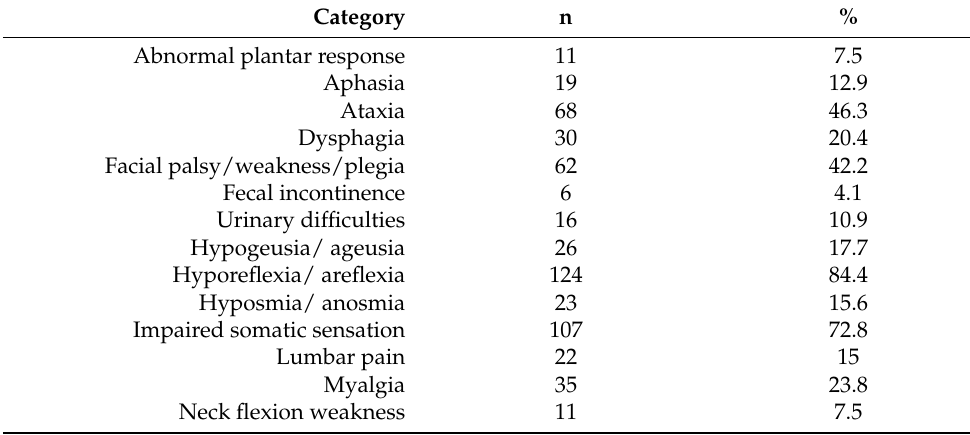
Table 2. Neurophysiological